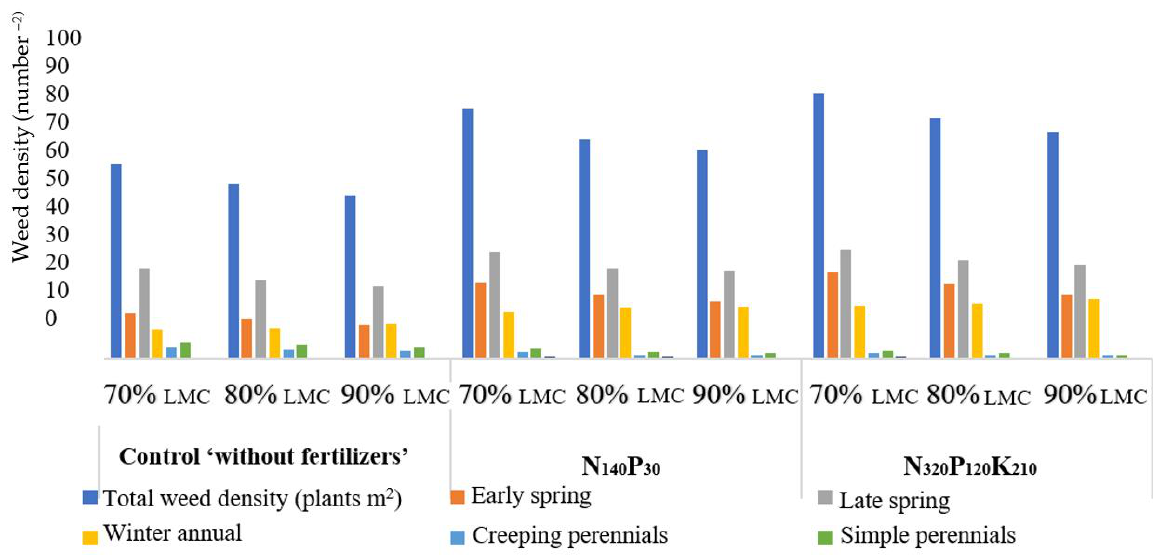
Figure 4. Weed dynamic affected by different treatments 40 days after planting. Despite an increase in the total weed number of 23.9%, the population of late spring weeds decreased, and in contrast, the number of winter annual weeds increased from 17.2% to 21.3% with the use of 40 tons manure and N 140 P 30 at 20 days after transplanting eggplants. The number of perennial weeds generally diminished by applying fertilizers, such that the population of creeping weeds and simple weeds were reduced by 5.2 and 7.2%, respectively, compared with the control.